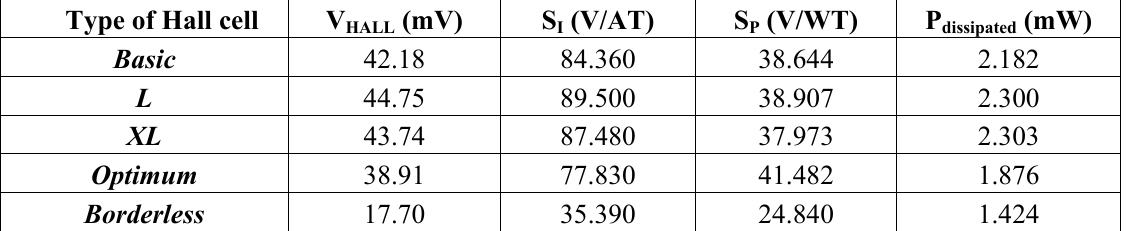
Table 3. Simulated Hall Effect devices performance